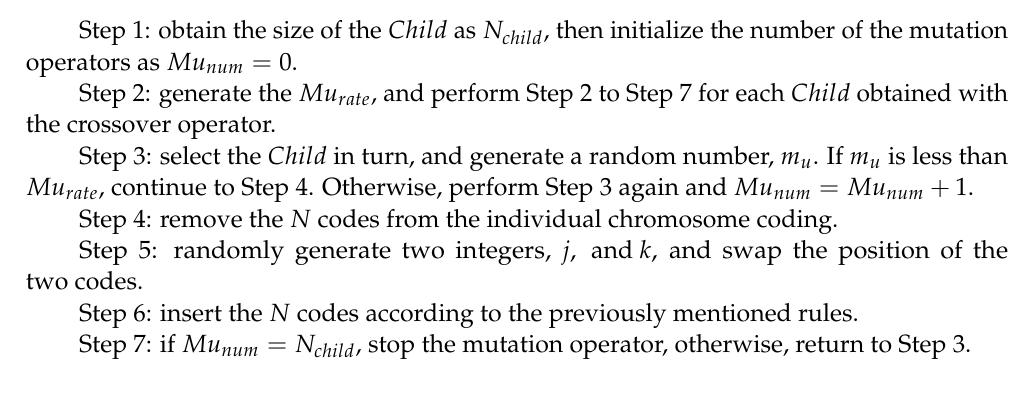
Figure 9. The flowchart of the GA*.